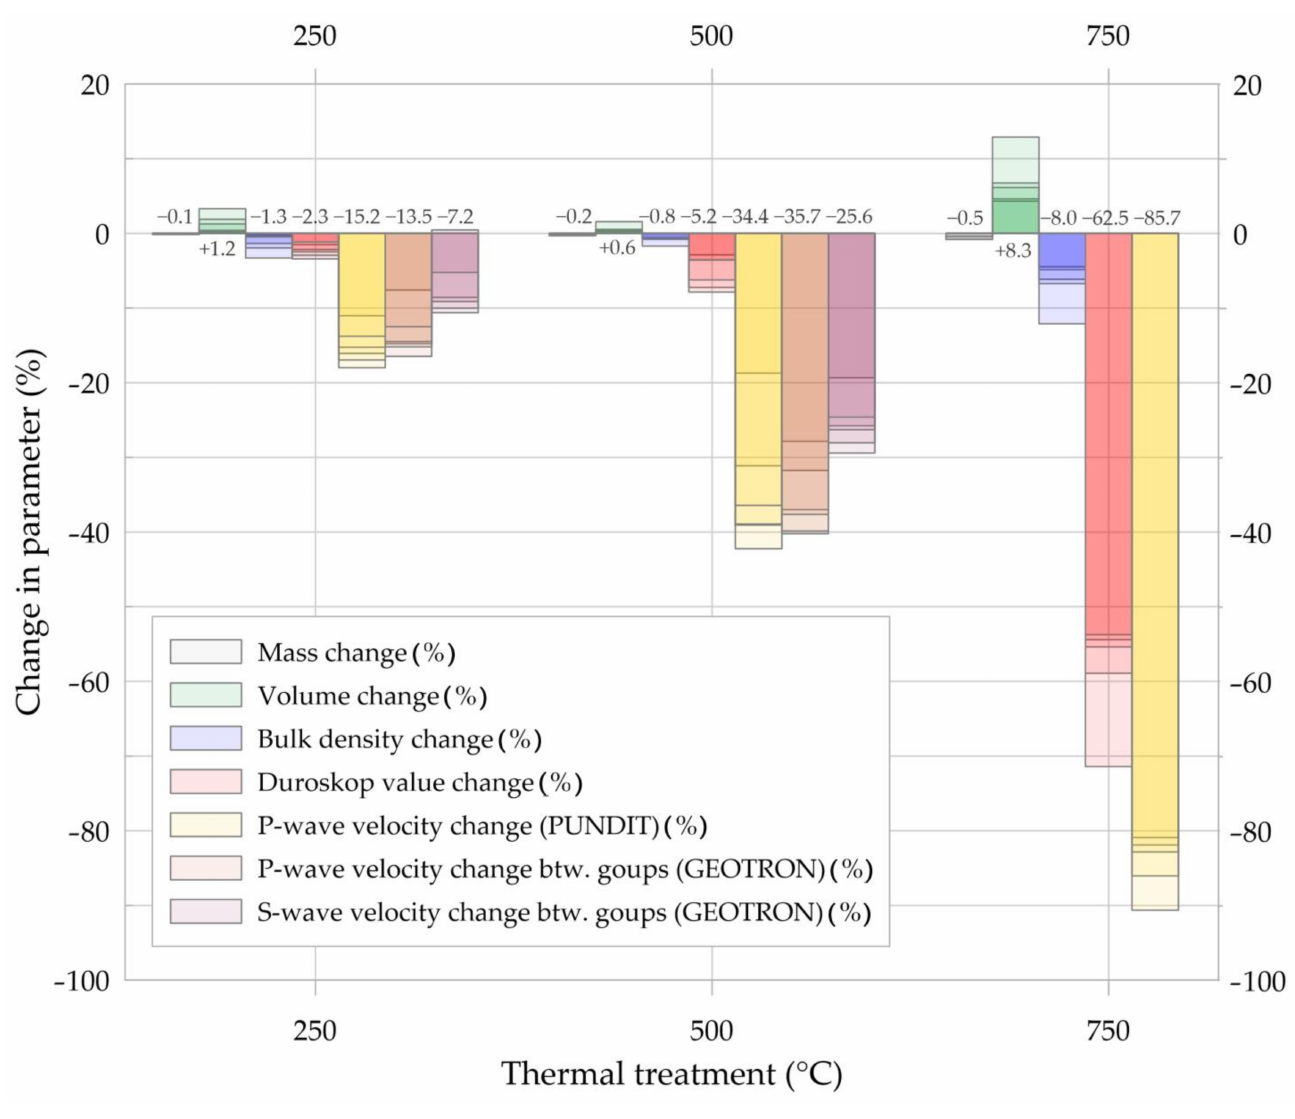
Figure 15. Bar plot of mass-, volume-, bulk density-, P-wave velocity (PUNDIT), P-wave velocity (GEOTRON) between groups, S-wave velocity (GEOTRON) between groups and Duroskop percental changes between untreated room tempera- ture and heat-treated